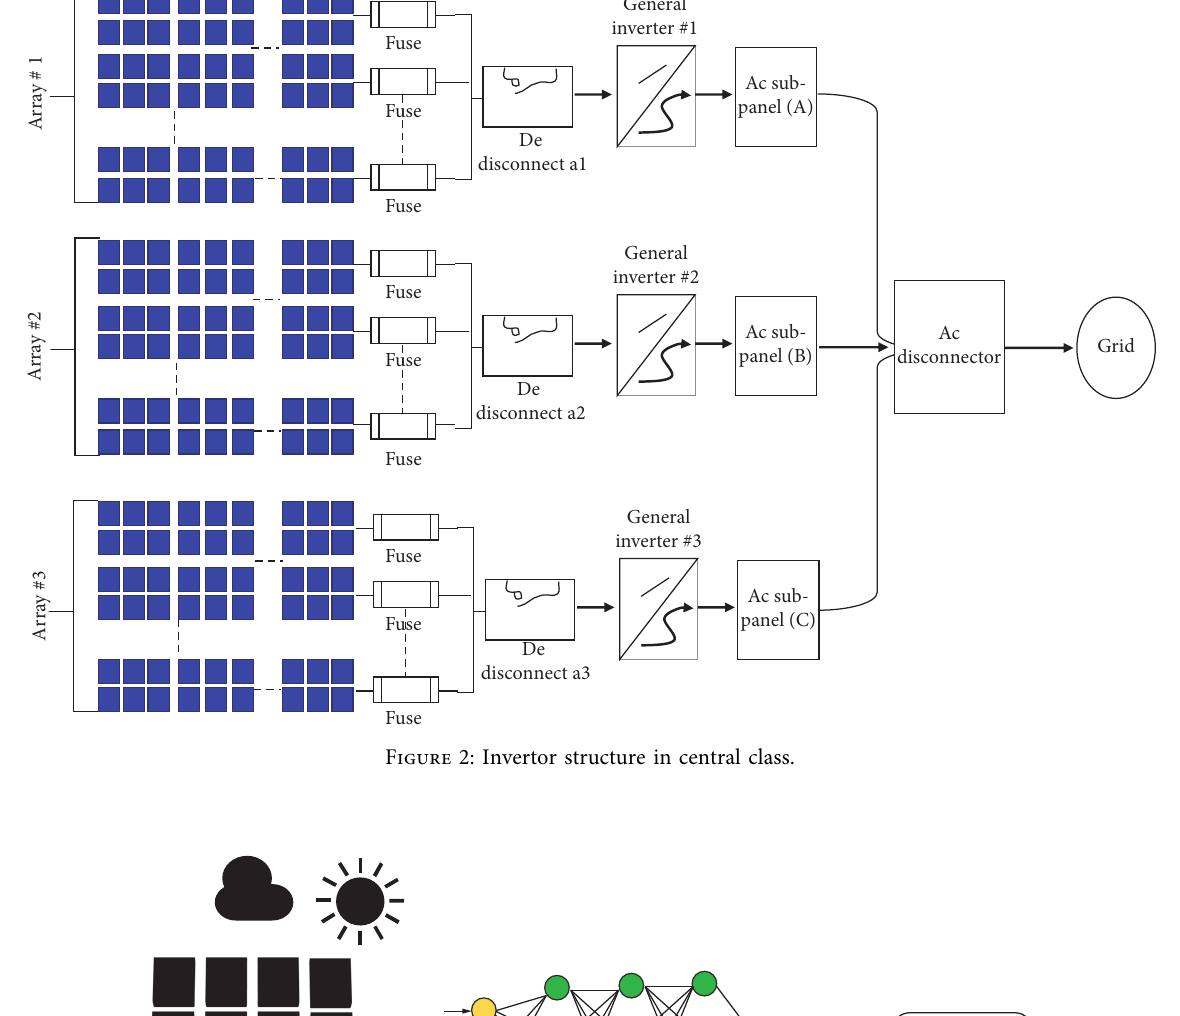
Figure 2: Invertor structure in central